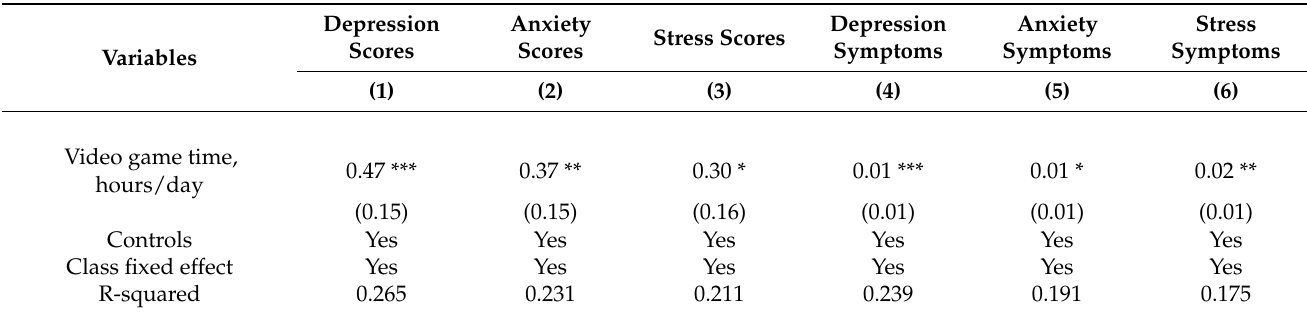
Table A3. OLS regression of weekly video game time on adolescent mental health, controlling for mobile phone